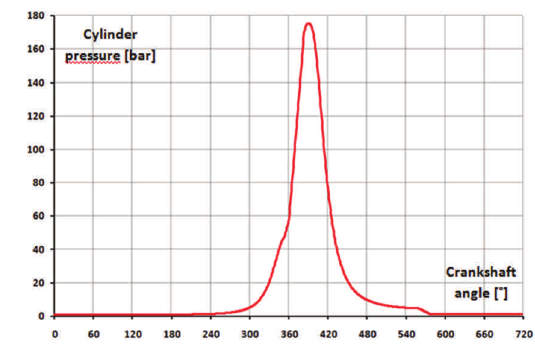
Fig. 11. Pressure inside the cylinder as a function of the angle of rotation of the crankshaft The loads were modeled using concentrated forces.